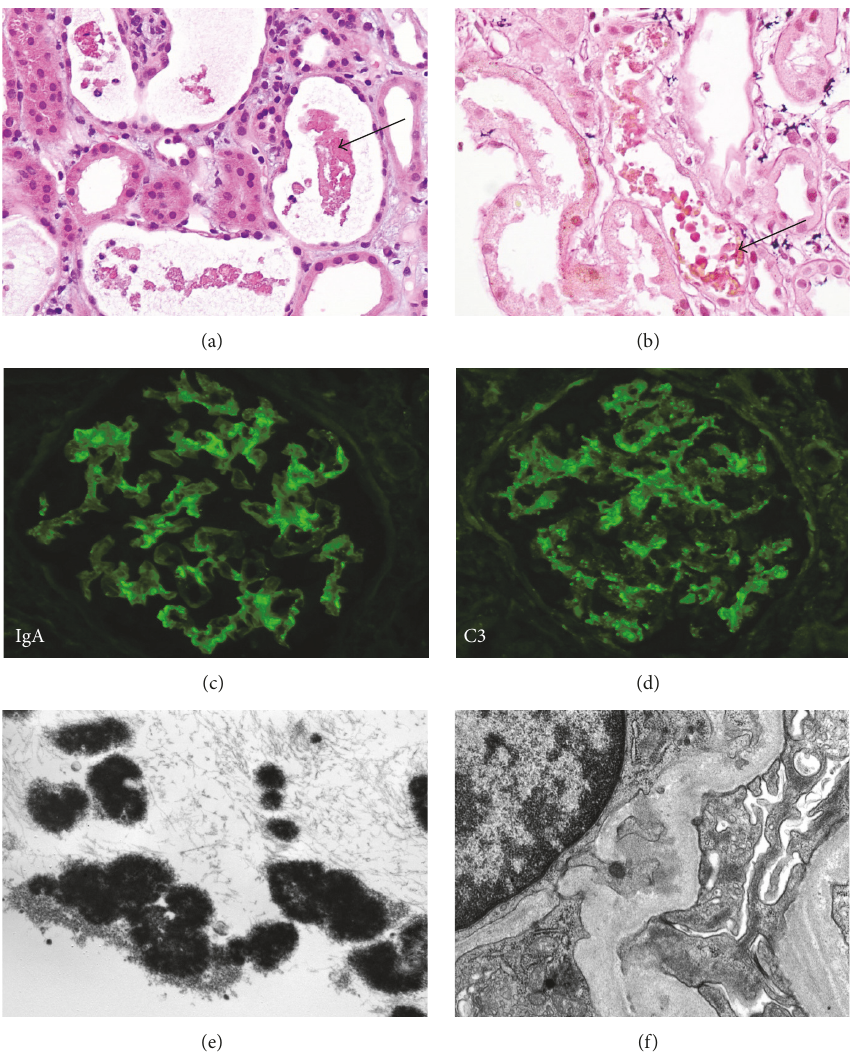
Figure 2: (a) Kidney biopsy showing acute tubular necrosis (ATN) with globular cast material in the tubules and interstitial edema (hematoxylin and eosin stained 200x). (b) Special stain for hemoglobin highlights yellow staining in the globular cast material (200x). ((c) and (d)) Direct immunofluorescence staining for IgA and C3 shows granular mesangial staining, respectively (400x). (e) Ultrastructural examination shows osmophilic globular hemoglobin casts in tubular lumen (uranyl acetate and lead citrate fixation, 10,000x). (f) Ultrastructural examination shows small scattered paramesangial electron dense immune-type deposits (uranyl acetate and lead citrate fixation,